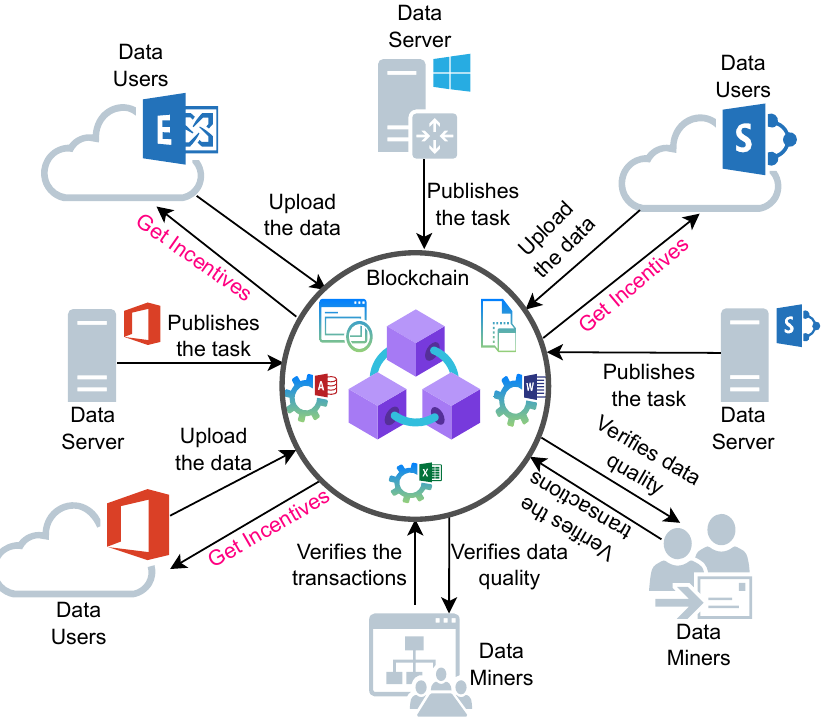
Figure 2. Blockchain model for providing incentives in